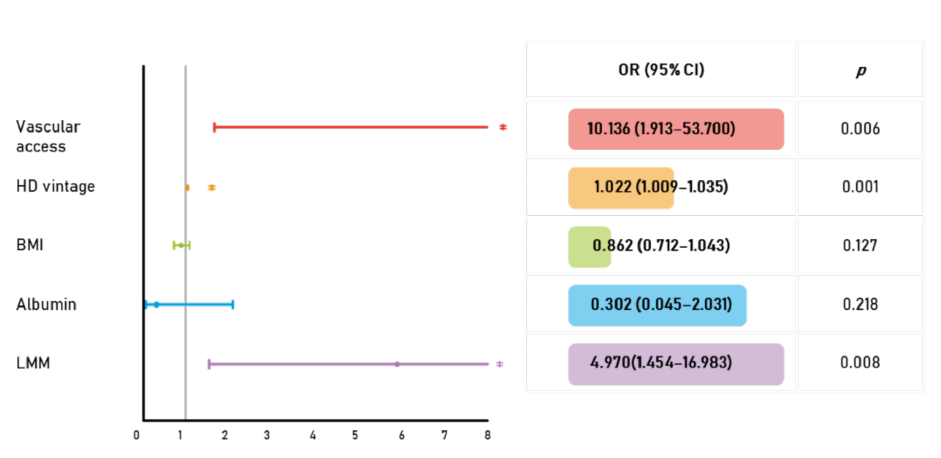
Figure 1. Multivariate logistic regression analysis of risk factors of vascular calcification (VC) : Forest plot (left) and odds ratios for the association between LMM and VC after adjustment for multiple confounders. The presence of an arteriovenous graft, longer hemodialysis duration, and low muscle mass were independent predictors of VC. * p < 0.05. AVG, arteriovenous graft; AVF, arteriovenous fistula; HD, hemodialysis; BMI, body mass index; LMM, low muscle mass; OR, odds ratio; CI, confidence